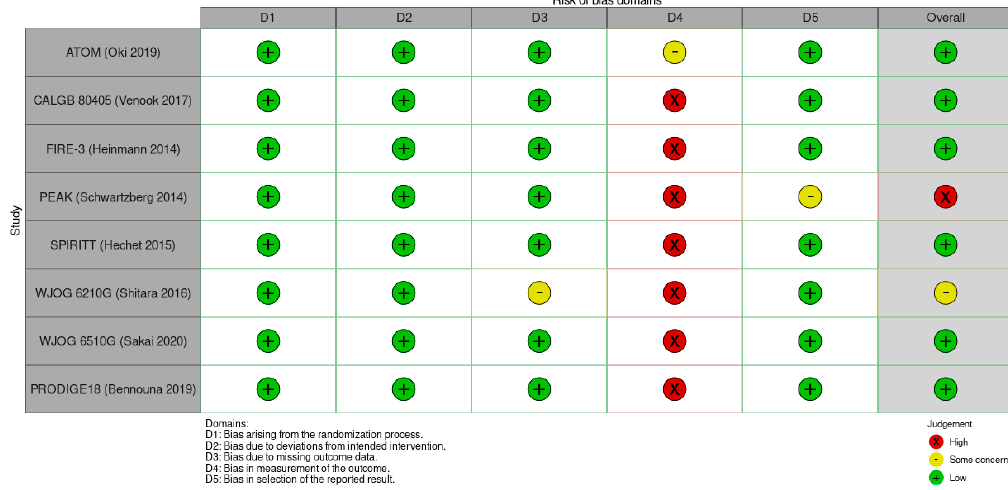
Figure 2. Study quality assessment per RoB 2.